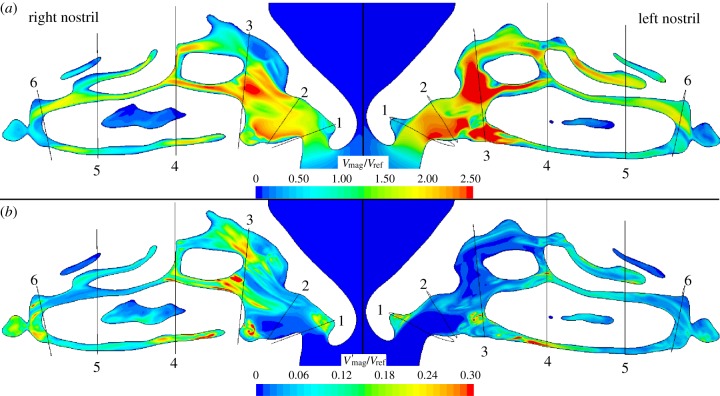
(a) Mean Vmag and (b) V′mag in the nose at peak flow, scaled by local reference velocities.